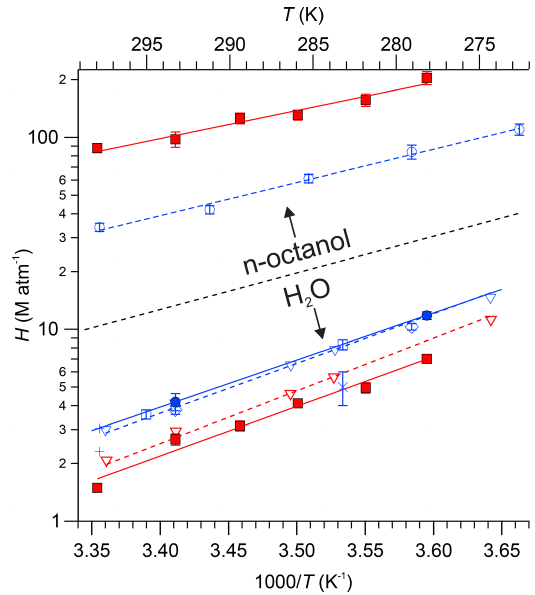
Figure 6. Natural logarithm of k l of PAN (blue colour) and PPN (red colour) in DI water and n -octanol plotted versus 1000 /T . Data from this work are shown as solid symbols ( • for PAN and (cid:3) for PPN). Literature data: × Holdren et al. (1984), (cid:52) Kames et al. (1991), (cid:79) and -- Kames and Schurath (1995), ♦ Frenzel et al. (2000), ◦ Roberts (2005). Error bars for the data by Roberts (2005) are omitted for clarity. The dashed blue and red lines (---) are the expressions by Kabir et al. (2014) for thermal dissociation of PAN and PPN, respectively. The dashed black line serves as a visual in- dicator to separate results obtained with n -octanol (bottom portion of graph) from those obtained with DI water